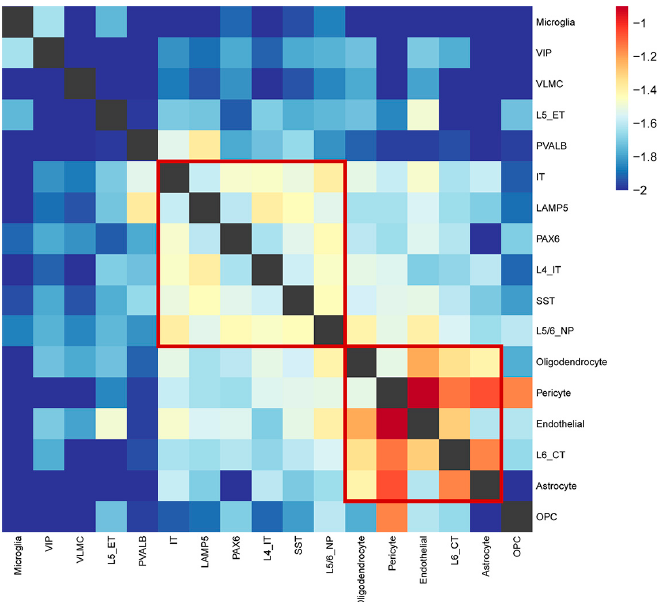
Figure 6. Heatmap showing neuronal and non-neuronal cell types grouped based on Jaccard simi- larity of the DEGs. Rows and columns correspond to cell types, and the intersection represents the Jaccard similarity between the two cell types. The red box indicates the cell types that converge to a module.